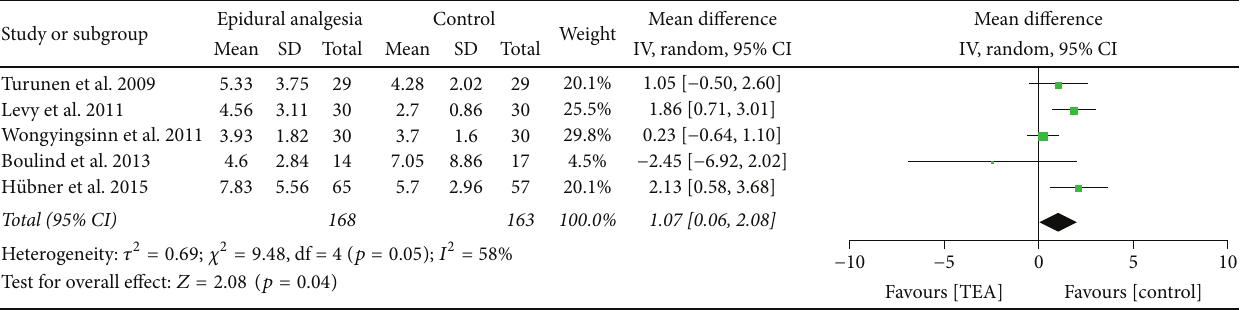
Figure 3: Hospital stay.